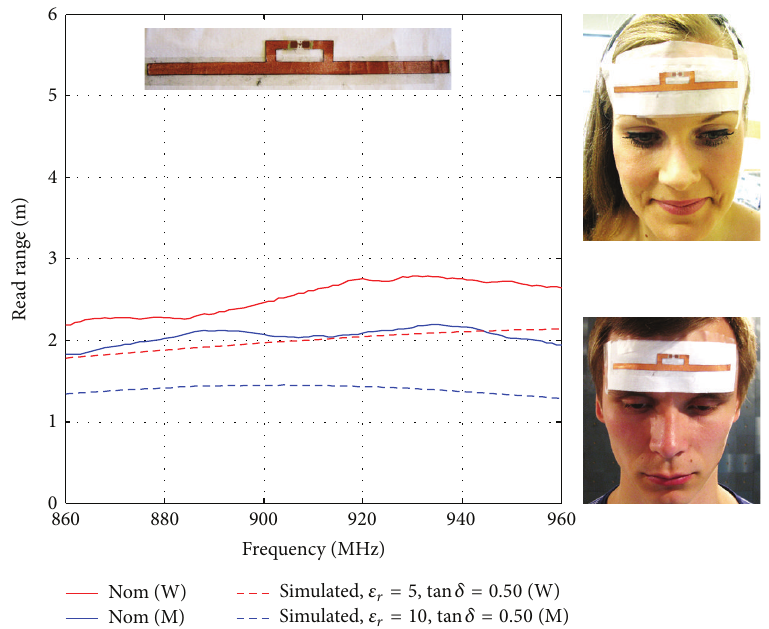
Figure 19: Measured and simulated fabric tag on human head and on human head model, respectively.